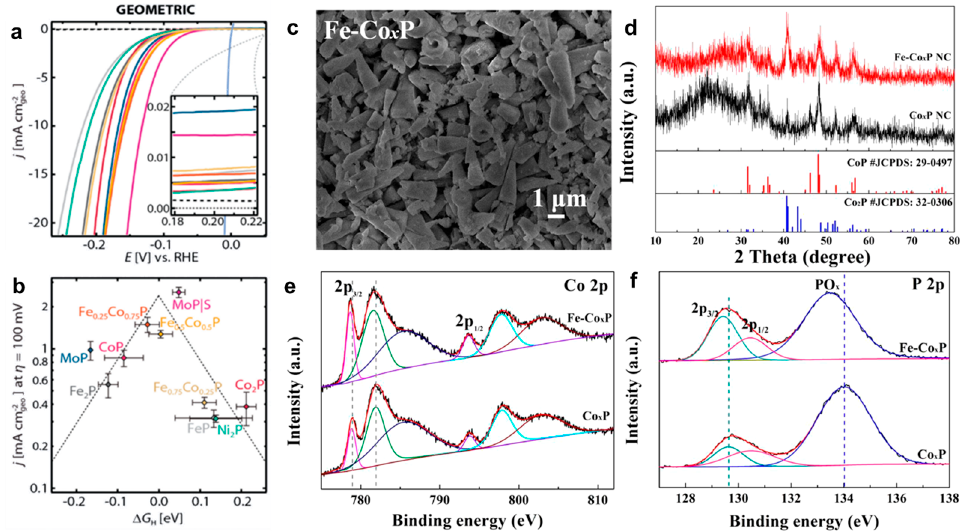
Figure 10. ( a ) The polarization curves per geometric area for transition metal phosphide electrodes. The inset figure is a zoom-in on a potential region. The polarization curve of Pt nanoparticles (NPs) is displayed for comparison; ( b ) activity volcano plot for HER performance, showing the geometric current density from (a) at η = 100 mV as a function of hydrogen adsorption free energy ( ∆ G H ), reproduced with permission from [8]. Copyright Royal Society of Chemistry, 2015. ( c ) SEM image of Fe-doped Co x P nanocones; ( d ) XRD patterns of Co x P and Fe-doped Co x P nanocones; XPS spectra of ( e ) Co 2p and ( f ) P 2p for Co x P and Fe-doped Co x P nanocones, reproduced with permission from